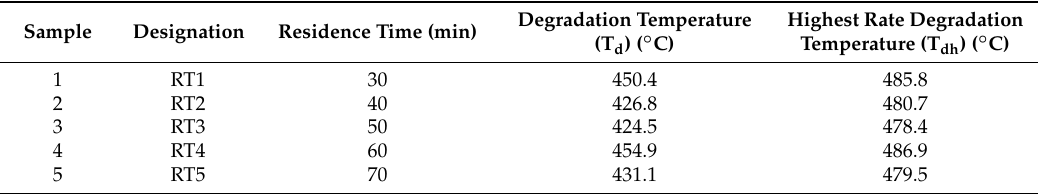
Table 4. Summary of TGA results showing the effect of barrel temperature on the degradation and the highest rate degradation temperatures of the fabricated